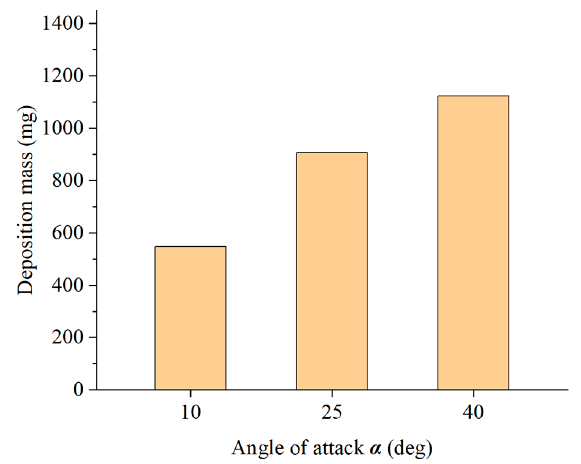
Figure 24. Comparison of deposition mass at angles of attack of 10 ◦ , 25 ◦ , and 40 ◦ .